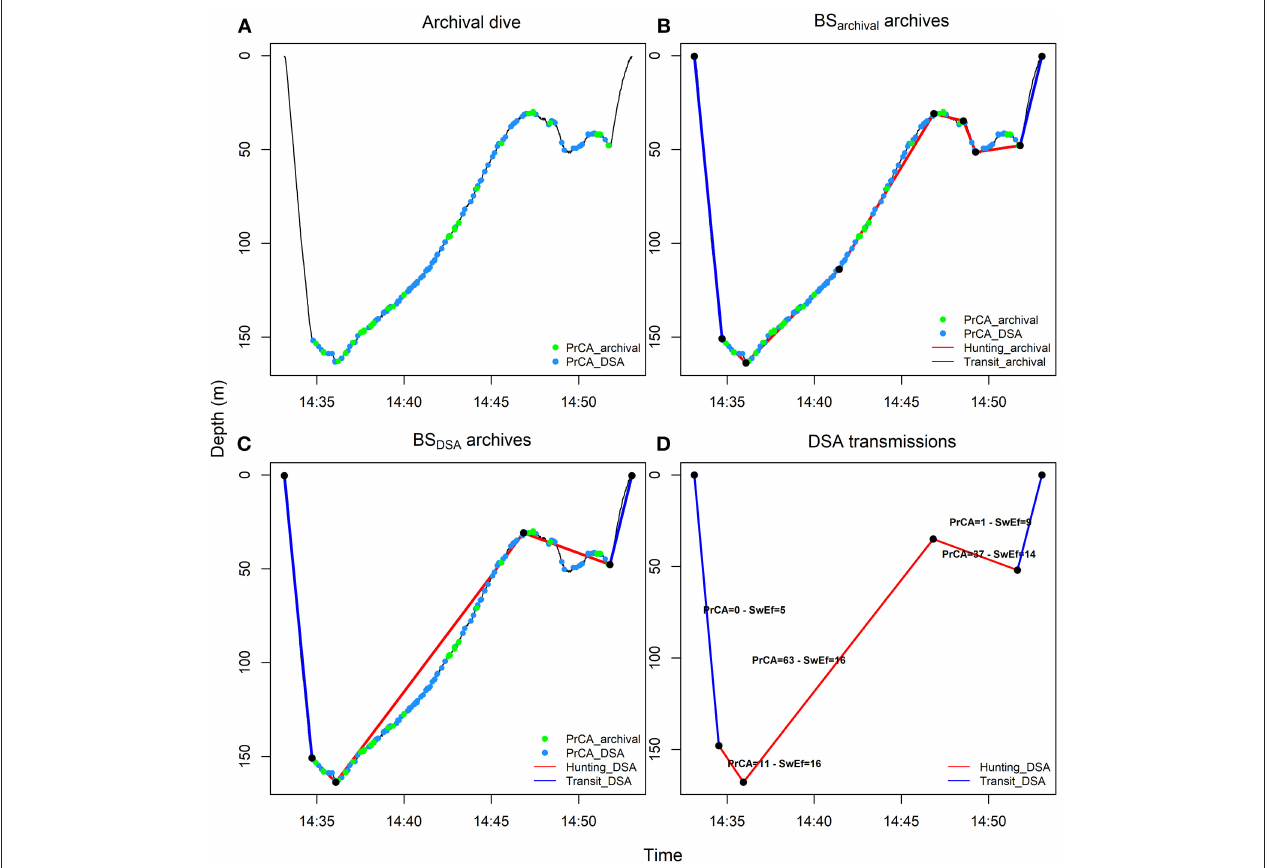
FIGURE 2 | From high-resolution to low-resolution dive profiles. High-resolution archived dives (A) were summarized by an optimal number of inflection points (BS archival archives) ( B , see methods and Heerah et al., 2014) and degraded in SRDL low-resolution dives (BS DSA summarized archives) ( C , see methods and Heerah et al., 2015). The corresponding dives were also transmitted, along with the associated swimming efforts (Swim effort, expressed in m · s − 3 ) and time spent in PrCA DSA behaviors per segment (D) (see also Figure 1 ). For the later, acceleration records were automatically processed on board the DSA tag before transmission. Red lines represent broken stick segments associated with hunting archival ( B , sinuous phases of high-resolution dives, 0 < vertical sinuosity < 0.9) or hunting DSA ( C,D , segments associated with reduced vertical velocity of low-resolution dives, vertical velocity ≤ 0.5 m · s − 1 ) behaviors. Conversely, blue lines represent segments associated with transit archival ( B , straighter phases of high-resolution dives, 0.9 ≤ vertical sinuosity ≤ 1) or transit DSA ( C,D , segments associated with increased vertical velocity of low-resolution dives, vertical velocity > 0.5 m · s − 1 ) behaviors. The green and blue dots indicate seconds spent in PrCA archival (estimates from high-resolution archives using well established algorithms) and PrCA DSA (estimates from DSA algorithm before transmission) behaviors,